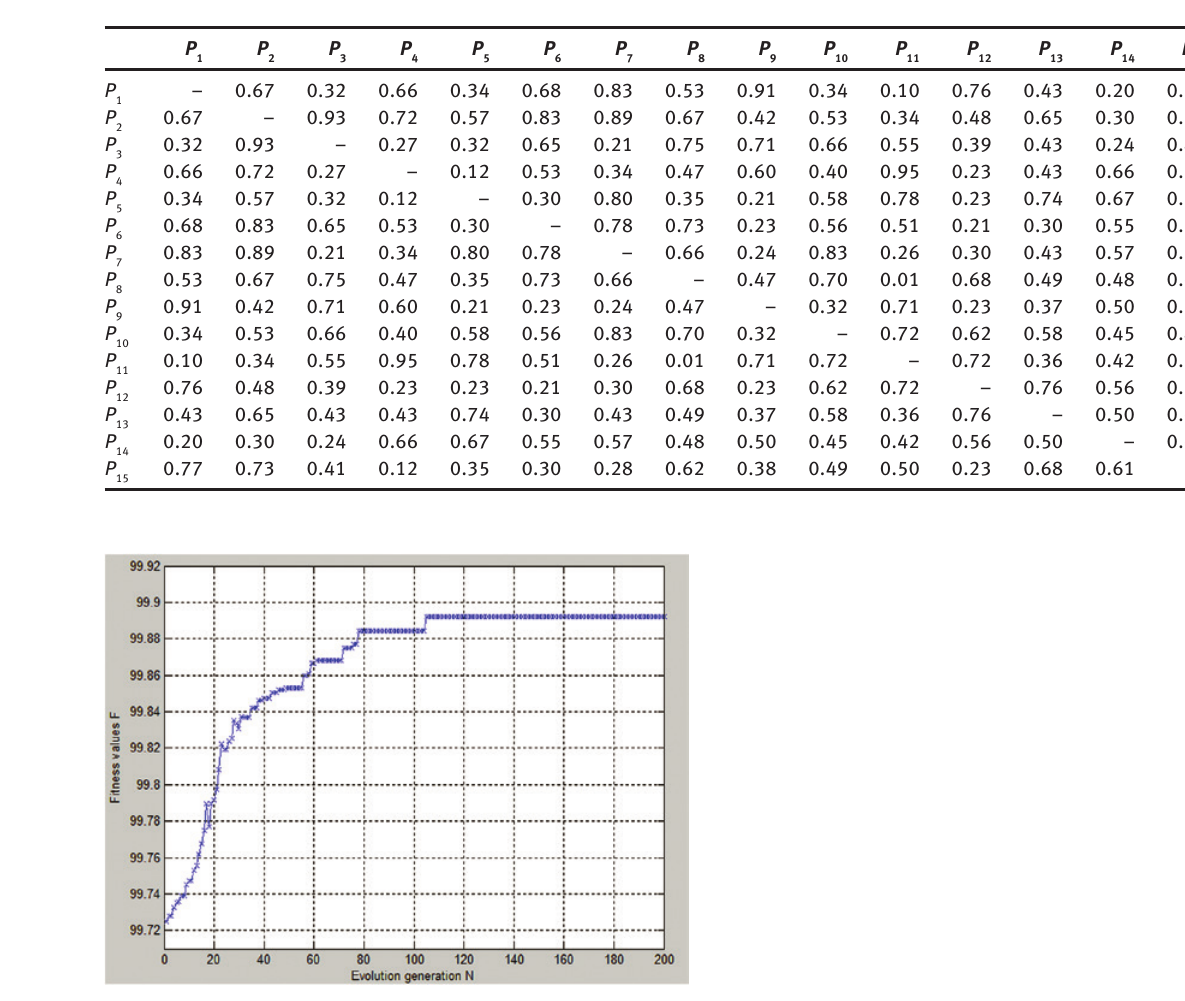
Table 9: Total Values of Collaboration Performance.